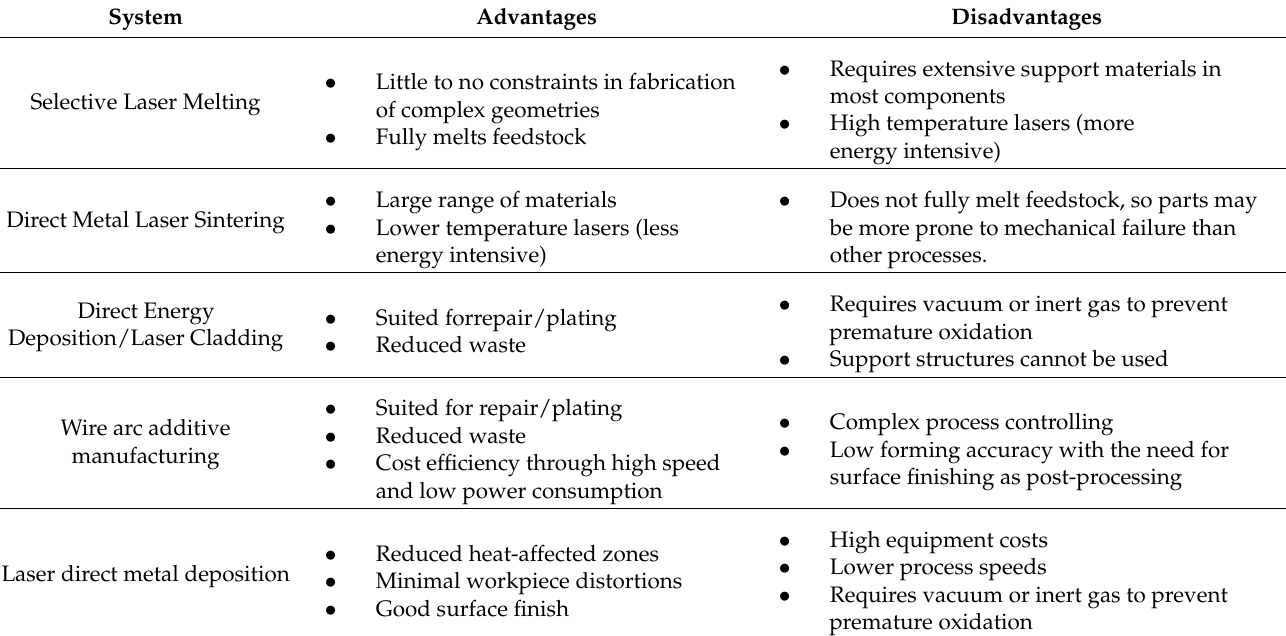
Table 1. Advantages and disadvantages of various metal AM